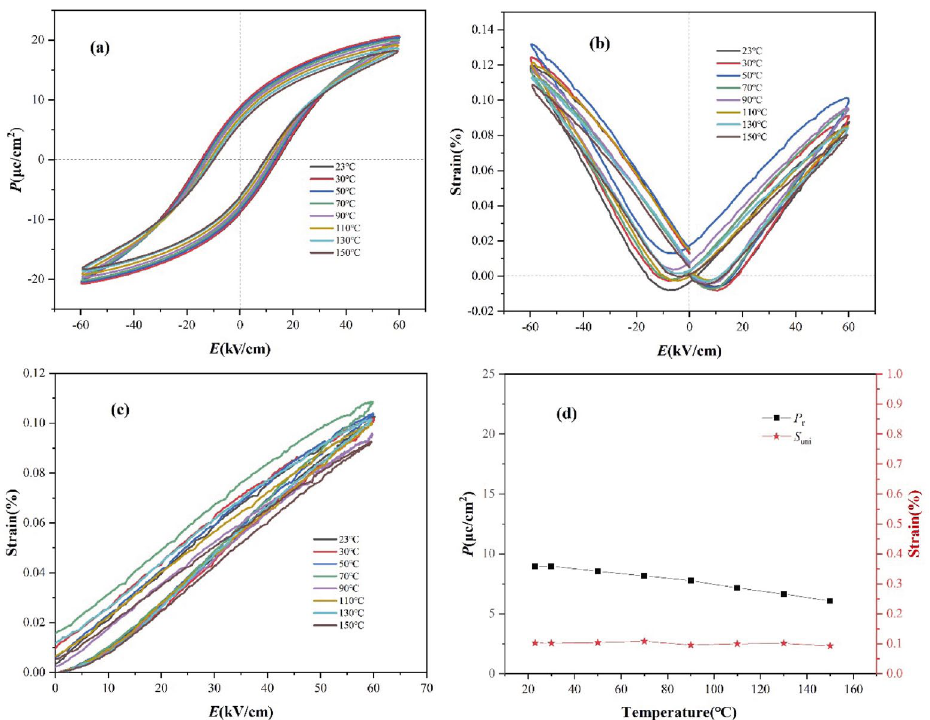
Fig. 5 (a) P–E hysteresis loops, (b) bipolar S–E curves, (c) unipolar strain curves of KNSN–0.04BNKZ– x Sm ( x = 0.002) ceramics at different temperatures; (d) the unipolar strain values for the above sample at different temperatures.